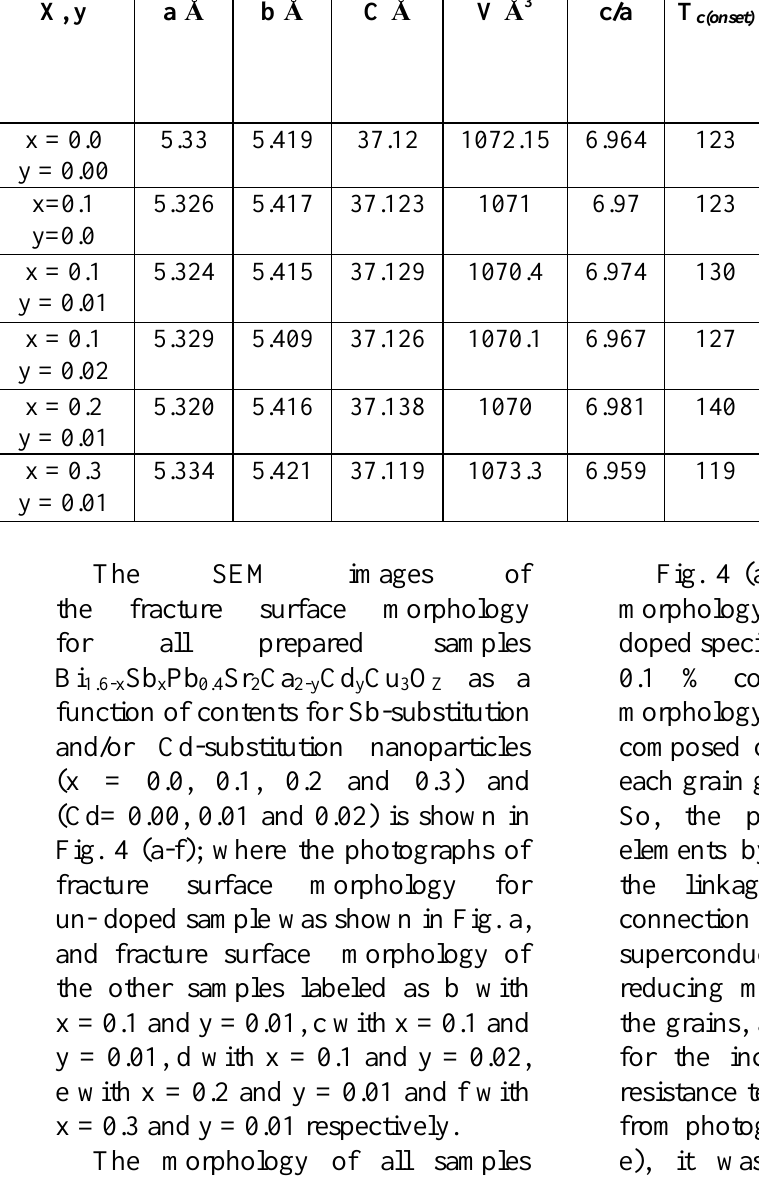
Table 1: Volume fraction of phases % for Bi with different concentrations of substitution Sb and